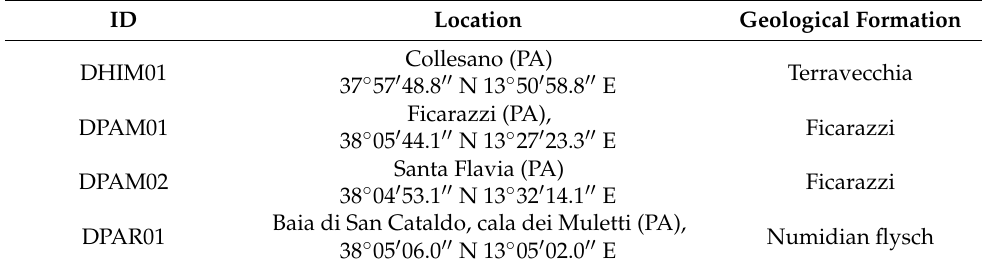
Table 2. Geological deposits sampled for this